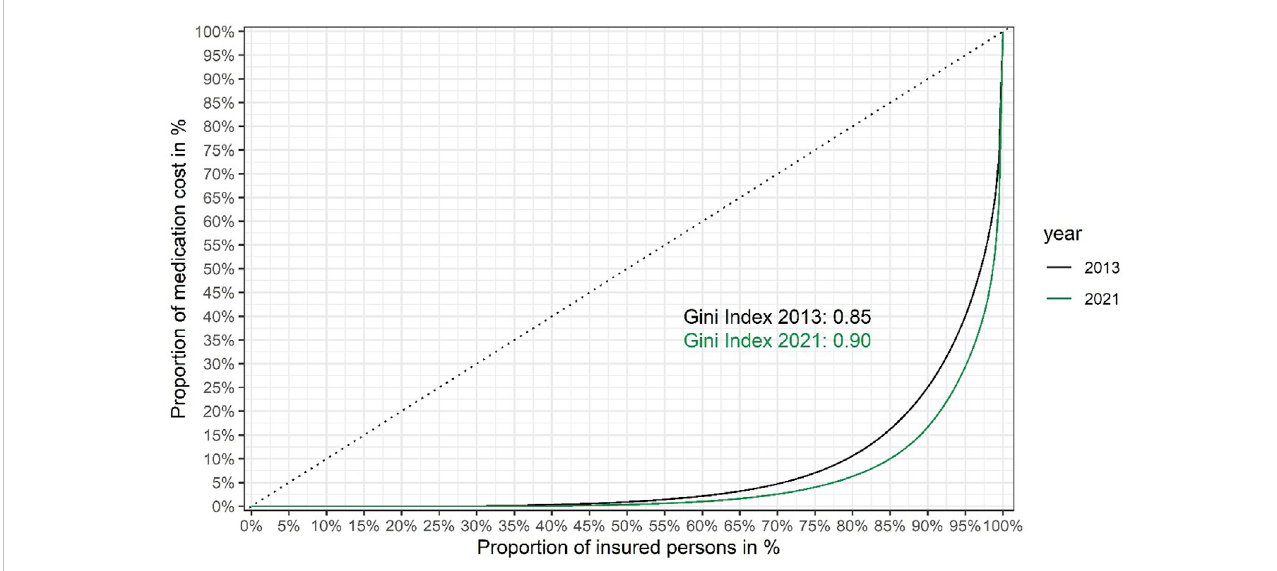
FIGURE 2 Lorenz curves showing inequality of medication cost per insured person in the Austrian public statutory health insurance in 2021 versus 2013. Insured persons are ranked from left to right based on their share of the total cost of medication to the Austrian public statutory health insurance (the total number of insured persons was around 9.2 million in 2021, versus around 8.7 million in 2013). The cumulative proportion of the total healthcare costs for each quantile are shown on the y-axis. The dashed diagonal line indicates cumulative costs in a hypothetical, completely equal scenario (i.e., where each insured person would consume the exact same share of the total medication costs). The Lorenz curves (solid lines) show the observed cumulative costs in 2021 and 2013, respectively. The Gini coef fi cients of inequality (0.90 and 0.85 in 2021 and 2013, respectively) were calculated from the respective Lorenz curves as twice the area between the diagonal line of complete equality and the Lorenz curve of the observed distribution of medication costs. Gini coef fi cients were calculated using the R package ineq. (Citation: Zeileis A. (2014). ineq: Measuring Inequality, Concentration, and Poverty. R package version 0.2 – 13, < https:// CRAN.R-project.org/package=ineq >